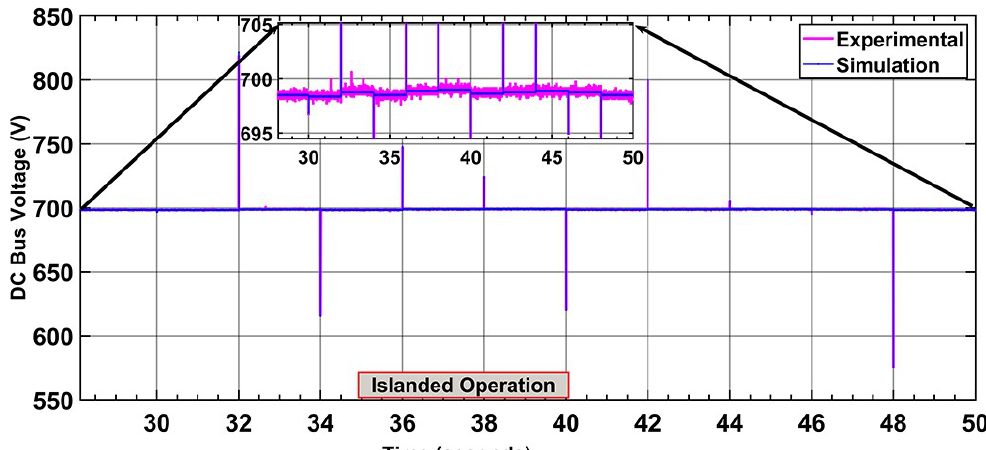
Figure 20. DC bus voltage during islanded mode.